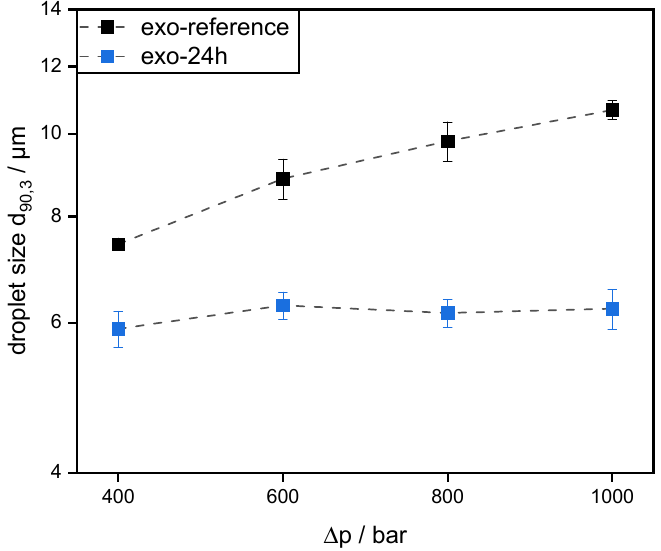
Figure 9. Droplet sizes d 90,3 of emulsions prepared with 0.5 wt% pectin with (exo-24h) or without (exo-reference) enzymatic modification using exo -polygalacturonanase. The emulsions were prepared at pH 3 with 30 wt% mct oil at varying energy densities.